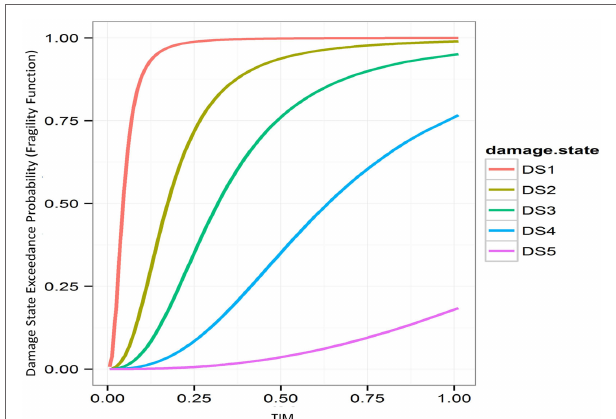
FIGURE 2 | Example fragility functions. IM, intensity measure; DS, damage state. The y -axis represents the probability of damage exceedance for each damage state ( P {ds < DS} versus